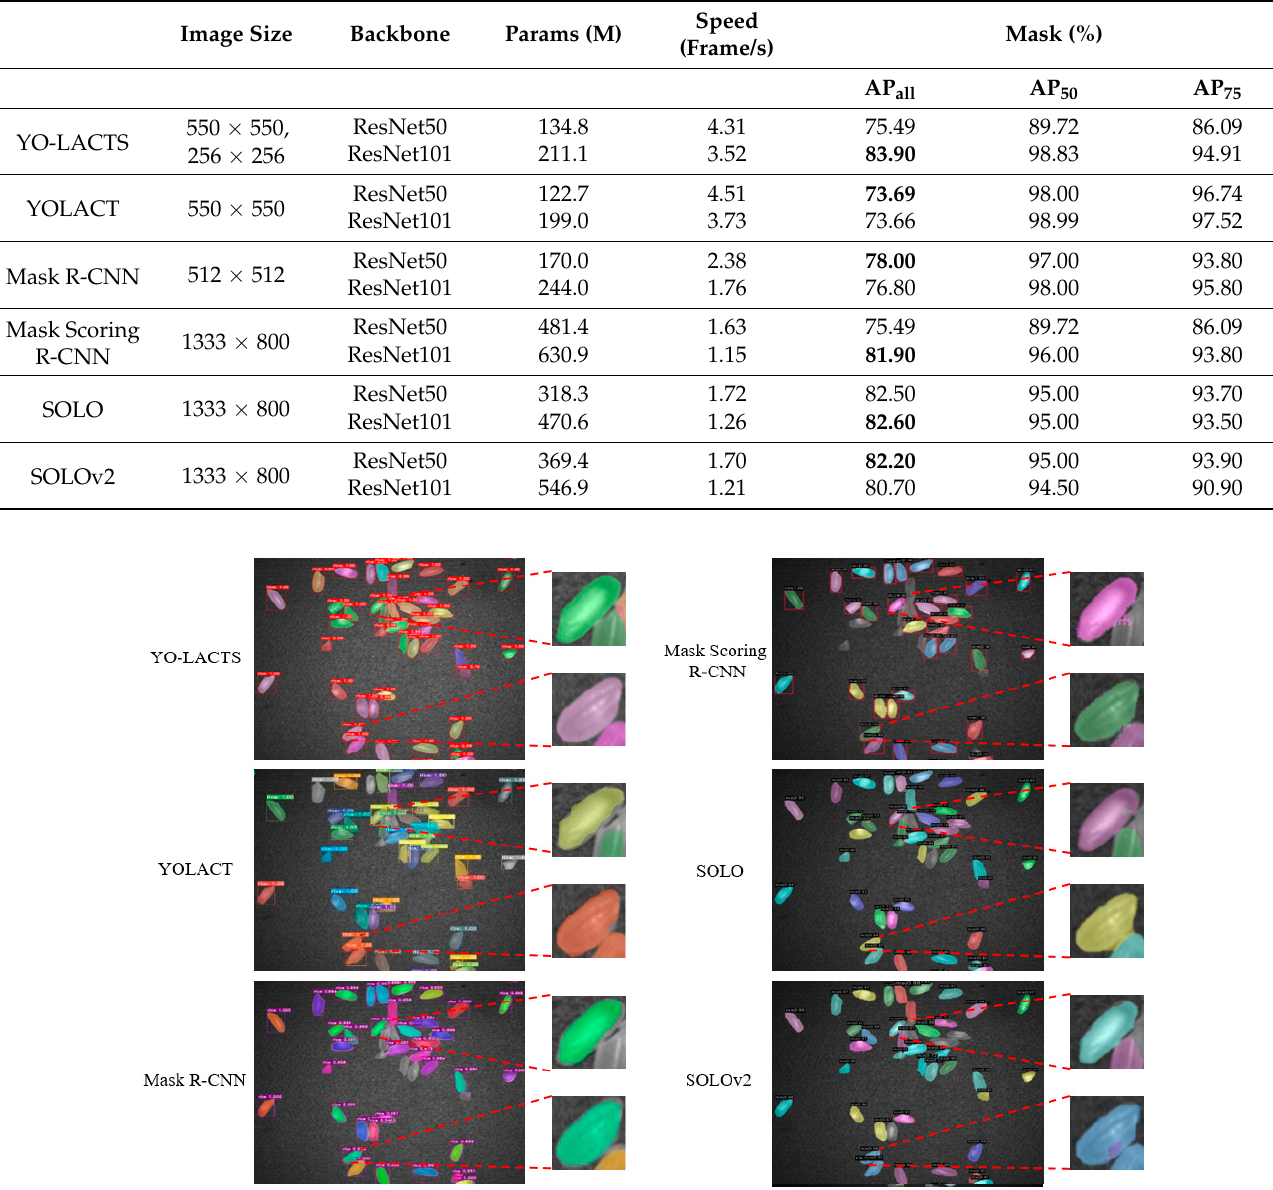
Table 4. Comparison between YO-LACTS and other methods.